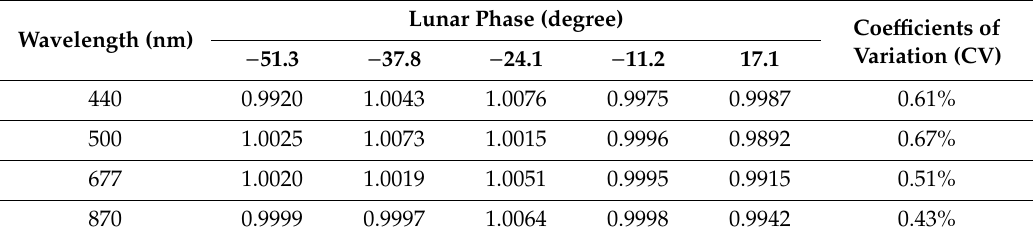
Figure 6. Normalized specific value of the CE-318U and imaging spectrometer with lunar phase. The ordinate is the normalized specific value D. Table 1. Normalized specific value and coefficients of variation